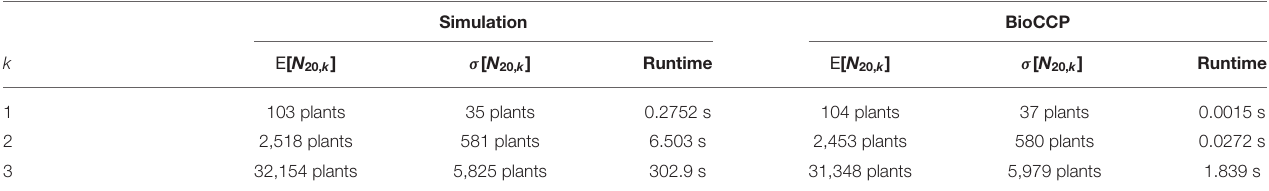
TABLE 3 | Statistics of N 20,1 , N 20,2 , and N 20,3 resulting from the simulation- and BioCCP-based approaches for the multiplex CRISPR/Cas experiments as specified by the default parameters in Table 2 .